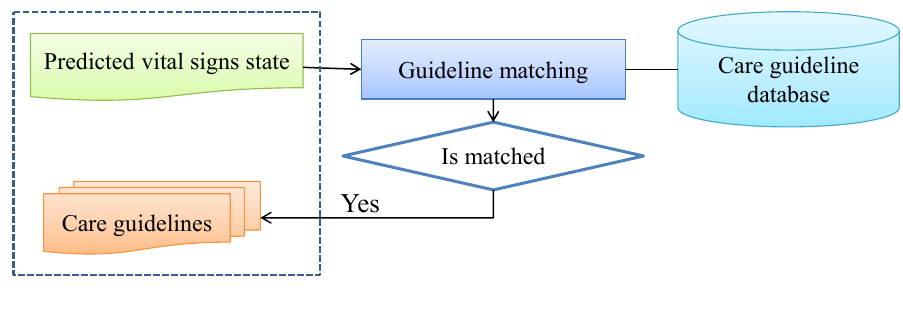
Figure 5. The flowchart of care guideline recommendation.